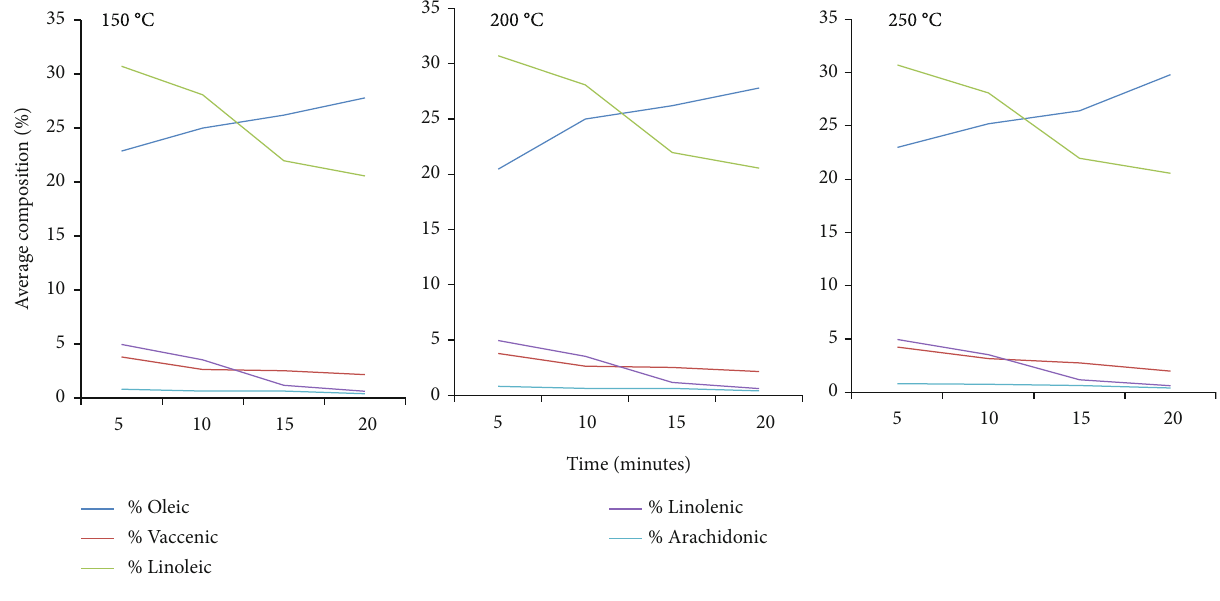
Figure 3: Percentage of unsaturated fatty acid composition with a variation of time and temperature.